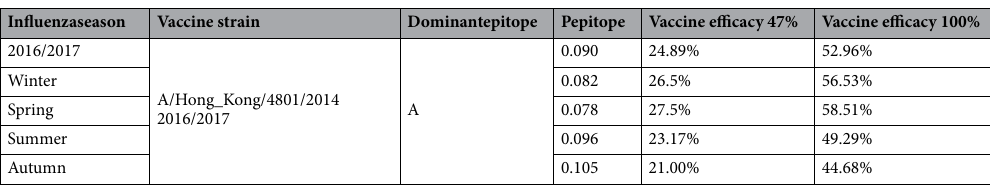
Table 1. Calculated vaccine efficacy using P epitope model in dominant epitope A of influenza A(H3N2) circulating in Shanghai port during 2016/2017, winter, spring, summer and